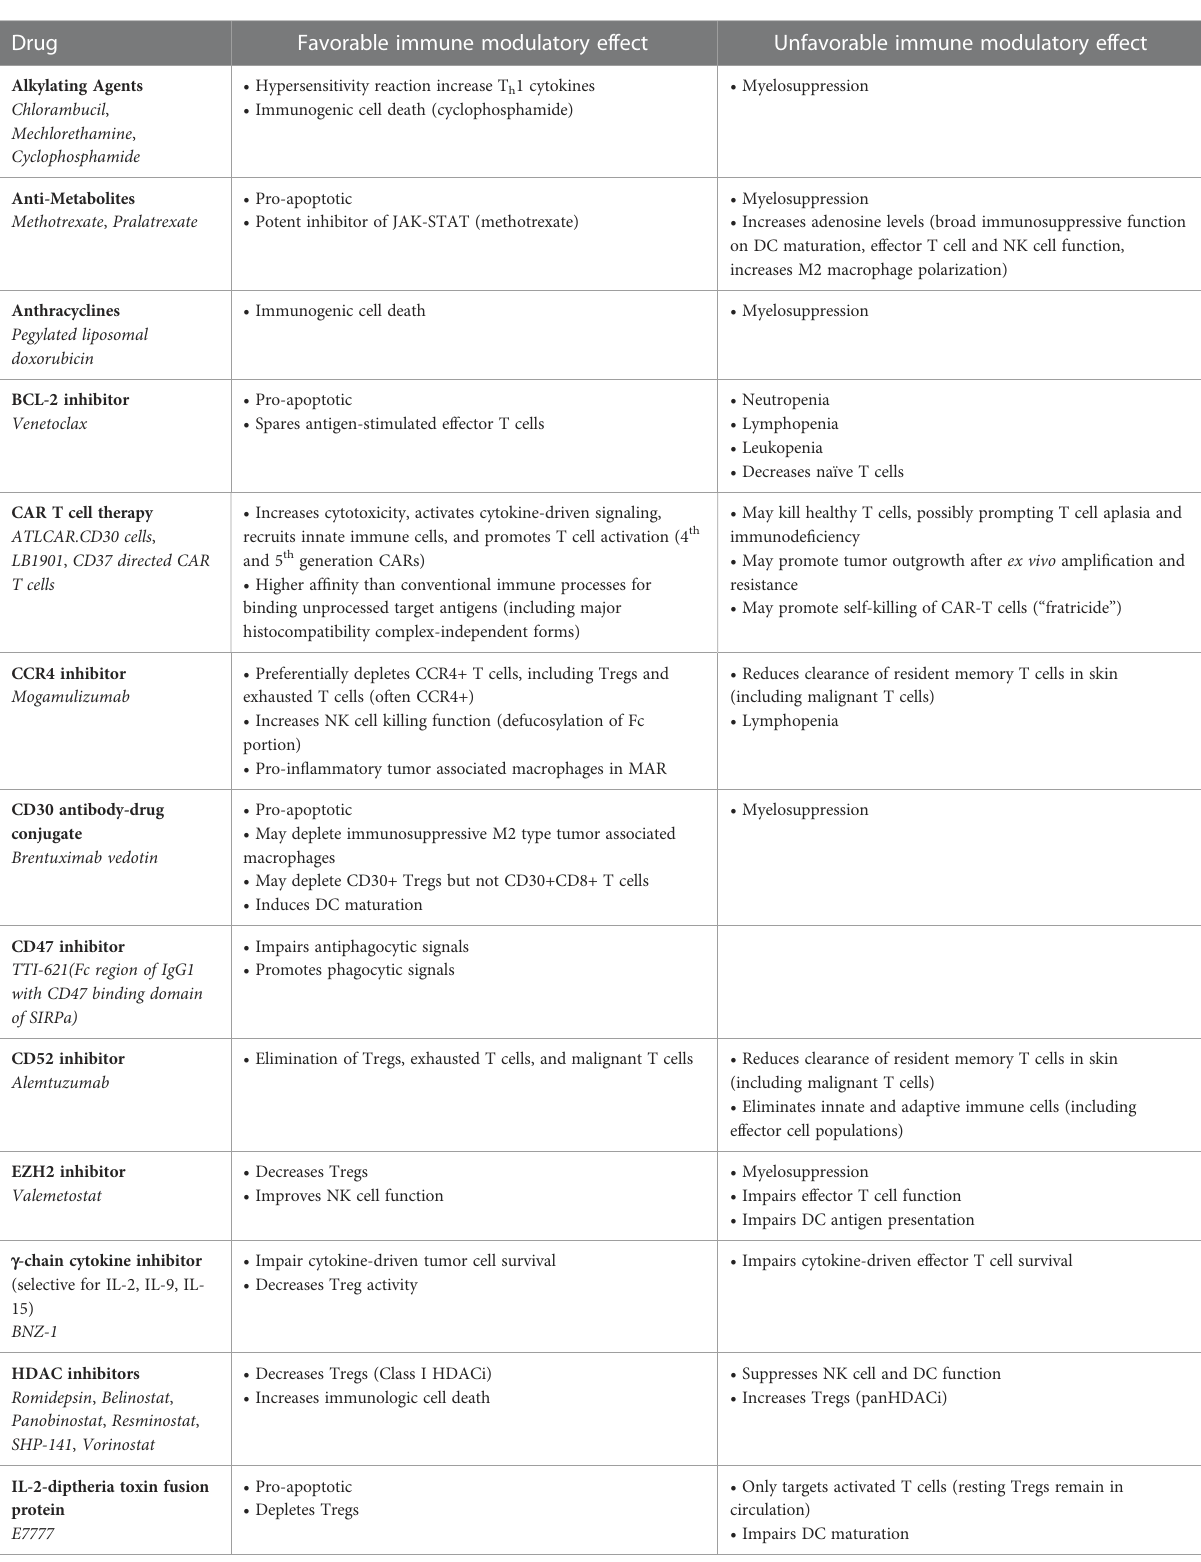
TABLE 1 Favorable and unfavorable immune modulatory effects of CTCL